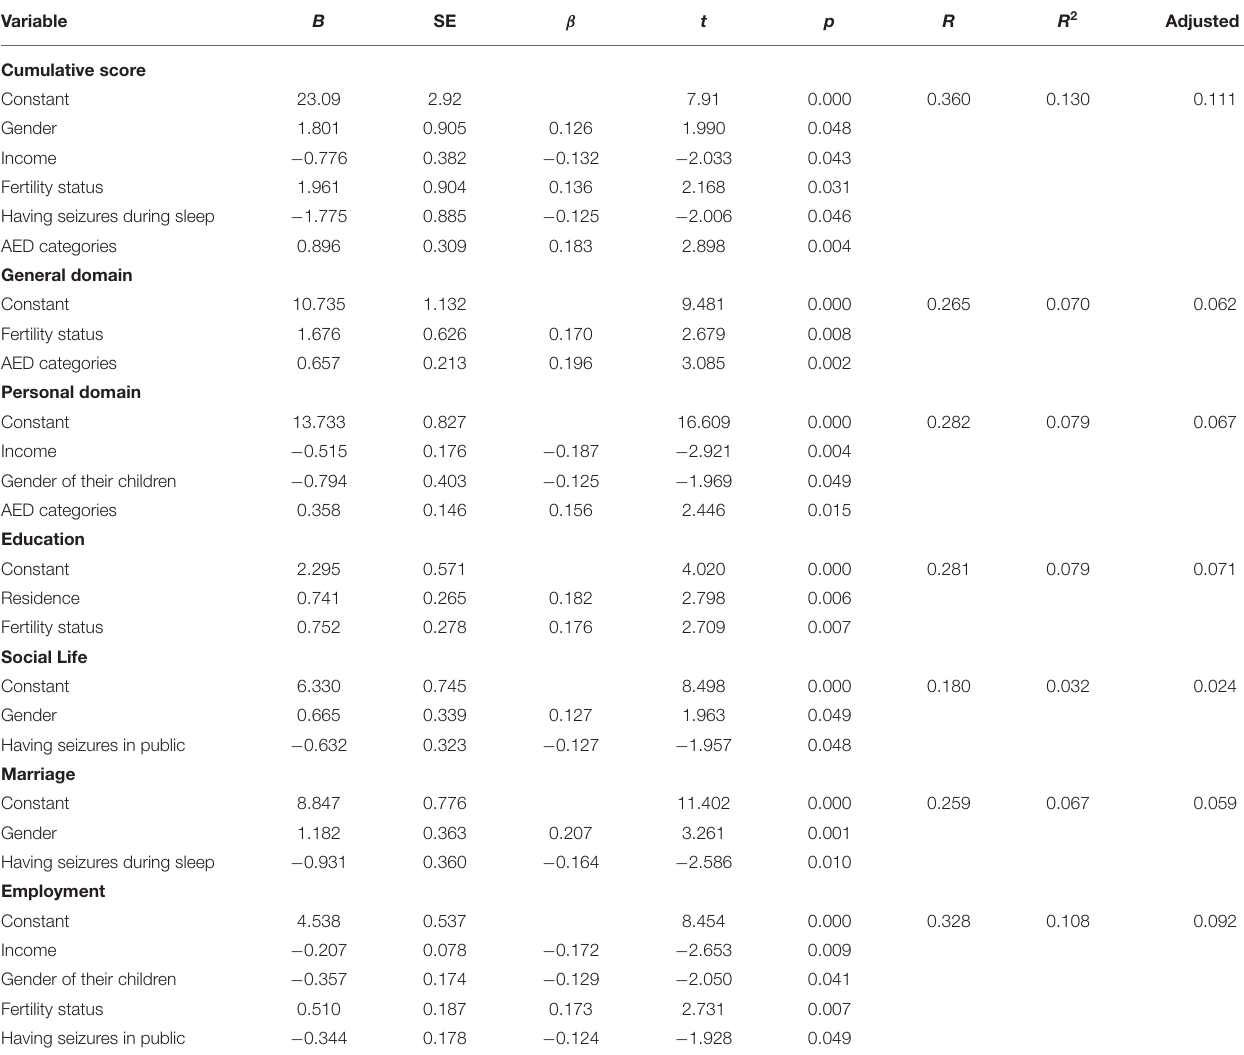
TABLE 4 | Results of multivariate analysis in domains and aspects of life among parents of children with epilepsy.